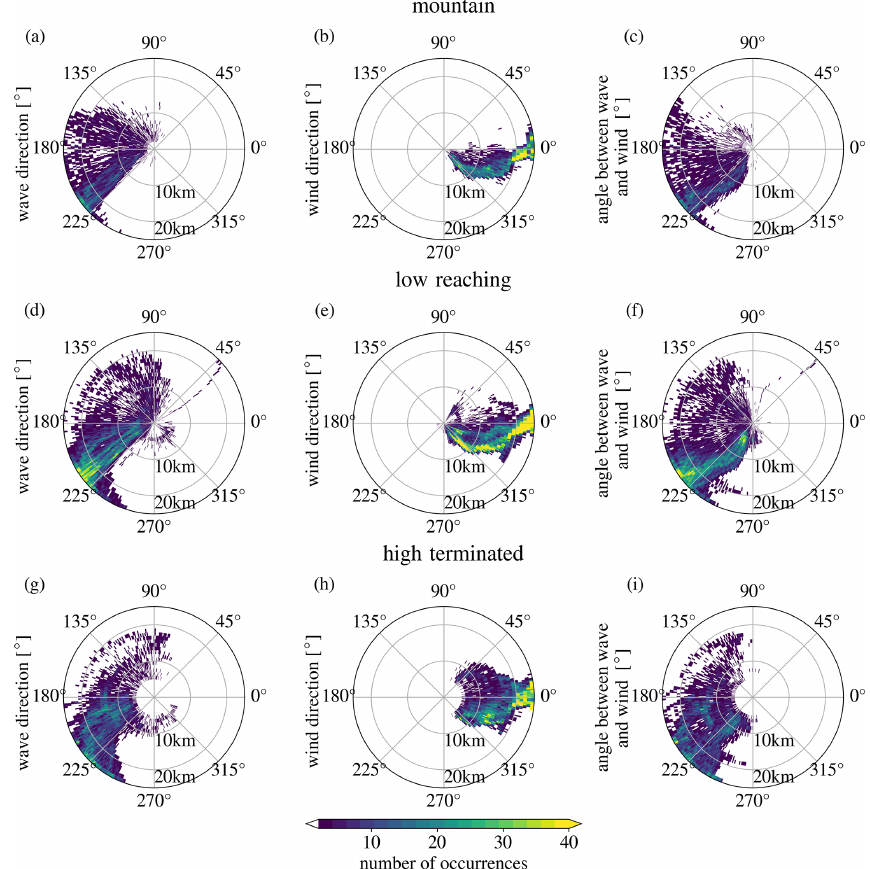
Figure 10. Polar maps of wind and wave directions along the GROGRAT rays binned into 0.5km altitude (radial) and 1 ◦ boxes. The colour maps shows the number of ray instances in the corresponding box. The left column shows the propagation direction with respect to the ground, the middle column the wind direction, and the right column the relative propagation direction to the